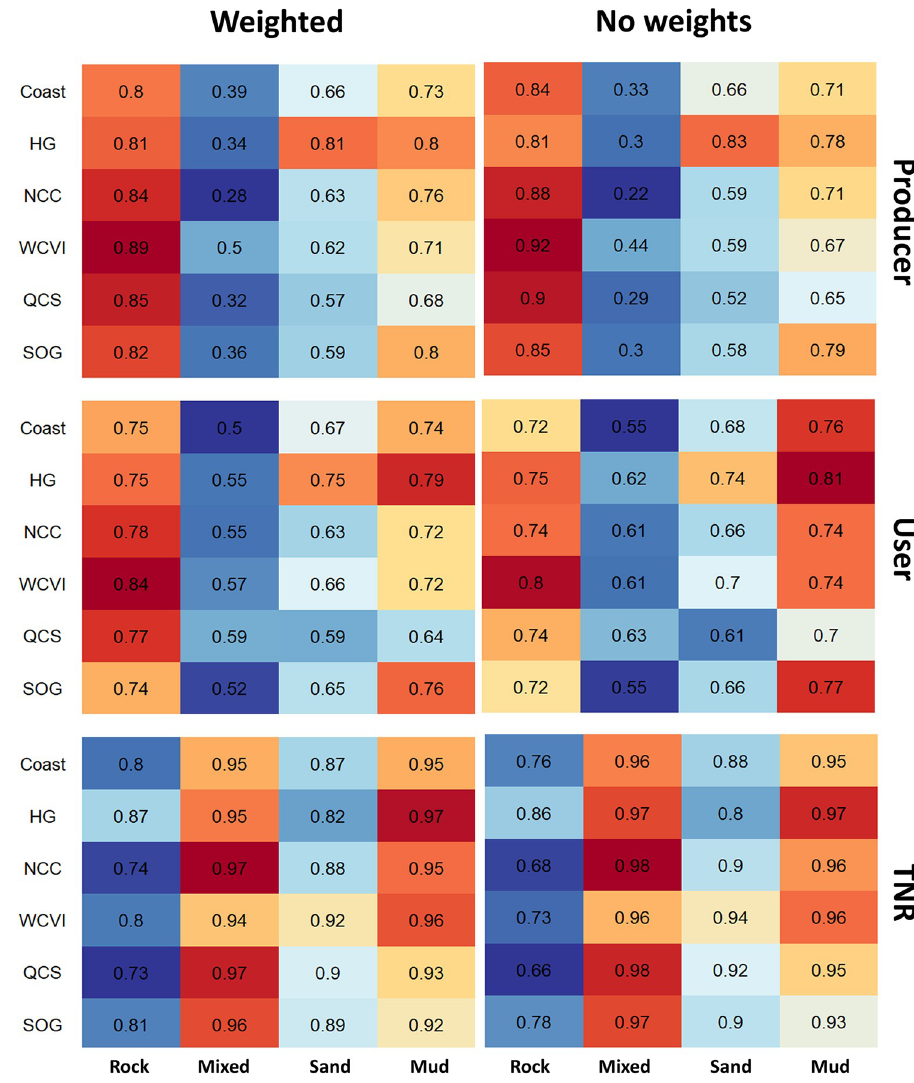
Fig 2. Heat maps of model performance. Producer Accuracy, User Accuracy, and True Negative Rate (TNR) for each substrate class, shown for weighted (left column) and non-weighted (right column) models. The color shading within each row reflects the underlying values from high (red) to low (blue) and is included to emphasize